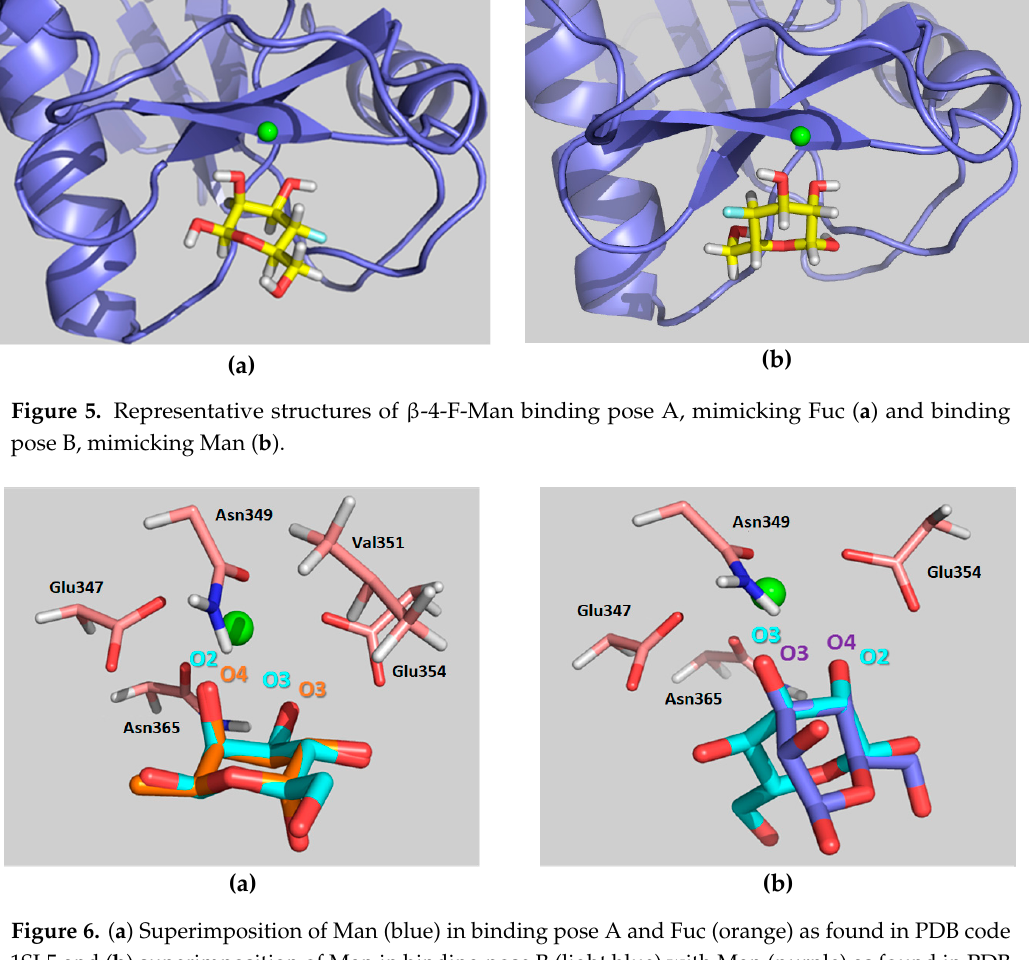
Figure 6. ( a ) Superimposition of Man (blue) in binding pose A and Fuc (orange) as found in PDB code 1SL5 and ( b ) superimposition of Man in binding pose B (light blue) with Man (purple) as found in PDB code 2IT5. Oxygen atoms that coordinate Ca 2+ are indicated in the same color as their sugar ring. The most relevant residues of the protein stabilizing the sugar at the binding site are shown in each case. All Man hydrogens, as well as the other residues forming the oligosaccharides contained in the original PDB structures have been removed for the sake of clarity.